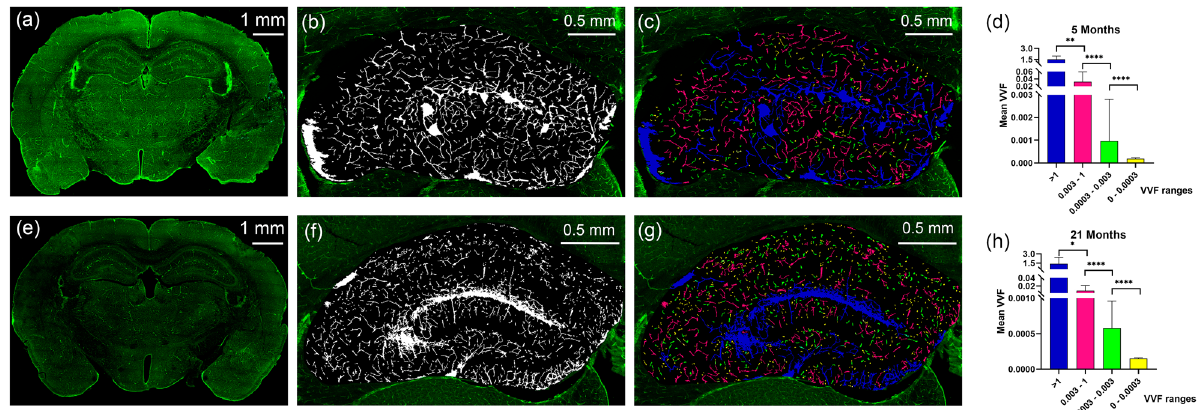
Figure 3. Vascular structure in the hippocampus analyzed by SLCM. ( a ) Tile-scan image of a coronal section for a 5-month-old mouse. The vascular endothelium marked with IB4 appears green. ( b ) Binary image in grey scale computed by the ImageJ automatic threshold function from the hippocampus in ( a ). ( c ) 3D counter object image showing the distribution of identified vessels. Vessels in the 0–0.0003, 0.0003–0.003, 0.003–1 and > 1 range were coloured yellow, green, fuchsia and blue, respectively. ( e )–( g ) Same as ( a )–( c ) but for a 21-month-old mouse. ( d ) and ( h ) show the mean vessel volume fraction (VVF) for all 5-month-old and 21-month-old mice included in this study, respectively. Significant differences were found for all ranges. For 5-month-old mice: χ 2 (4) = 30; [0–0.0003 vs. 0.0003–0.003] and [0.0003–0.003 vs. 0.003–1]: p < 0.0001, [0.003–1 vs. > 1]: p = 0.0006. For 21 month old mice: χ 2 (4) = 30; [0–0.0003 vs. 0.0003–0.003] and [0.0003–0.003 vs. 0.003–1]: p < 0.0001, [0.003–1 vs. > 1]: p = 0.0440. *p < 0.05, **p < 0.0021, ****p <